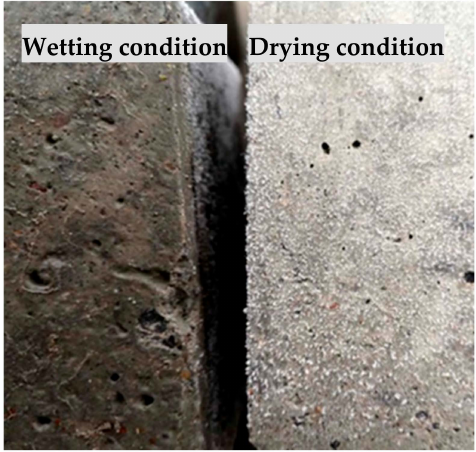
Figure 4. Comparison of salt crystal distribution on concrete surface between wetting and drying